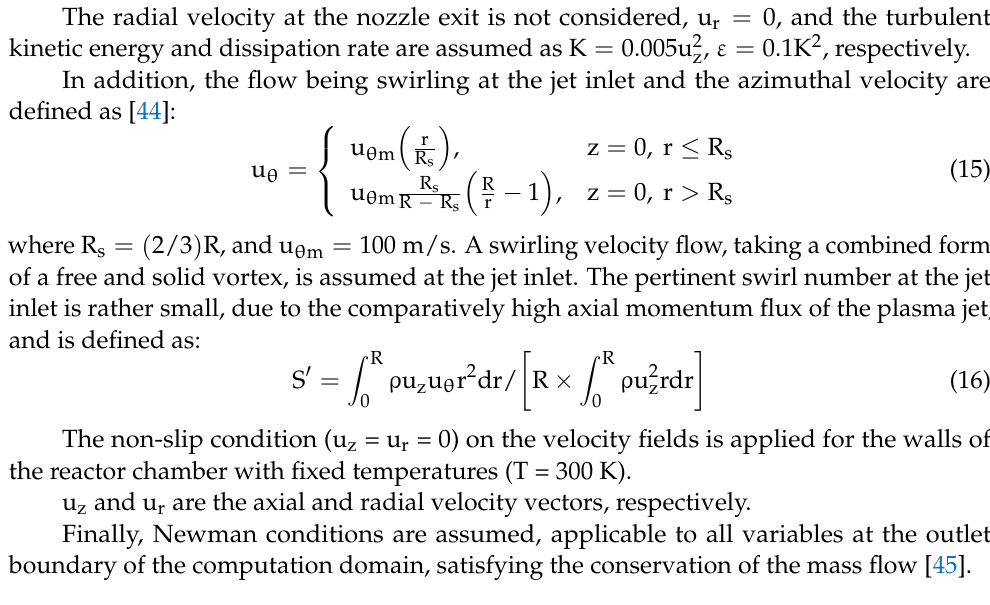
Figure 4. Distribution of velocity ( a ) and temperature ( b ) profiles at the plasma jet inlet as a function of radial distance, using a numerical model, experimental results, and polynomial